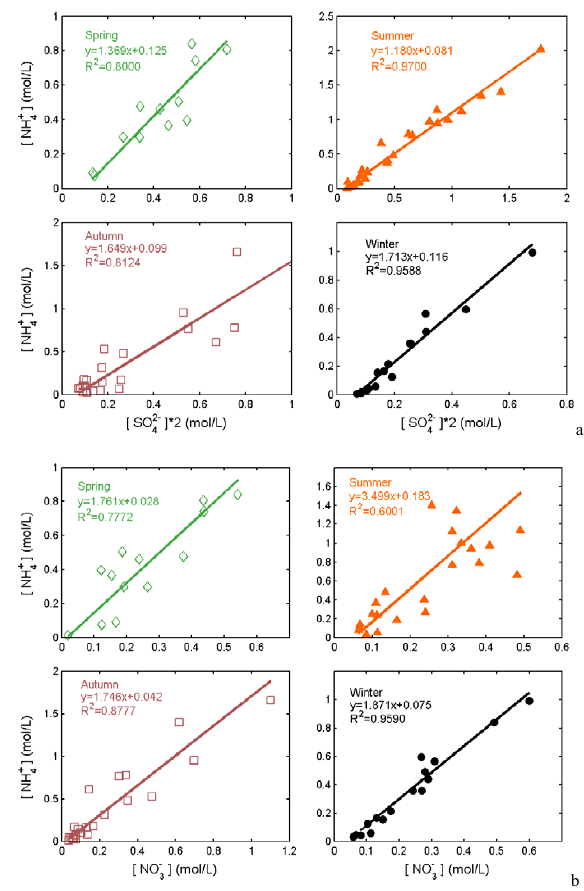
Fig. 11 The relationships of observed [NH 4+ ] concentrations vs. 2[SO 42- ] and [NO 3- ] concentrations in Fig. 11. The relationships of observed [NH + ] concentrations vs. 4 different seasons. The reduced major axis regression is performed for the linear fit. 2[SO 2 − ] and [NO − ] concentrations in different seasons. The re- 4 3 duced major axis regression is performed for the linear